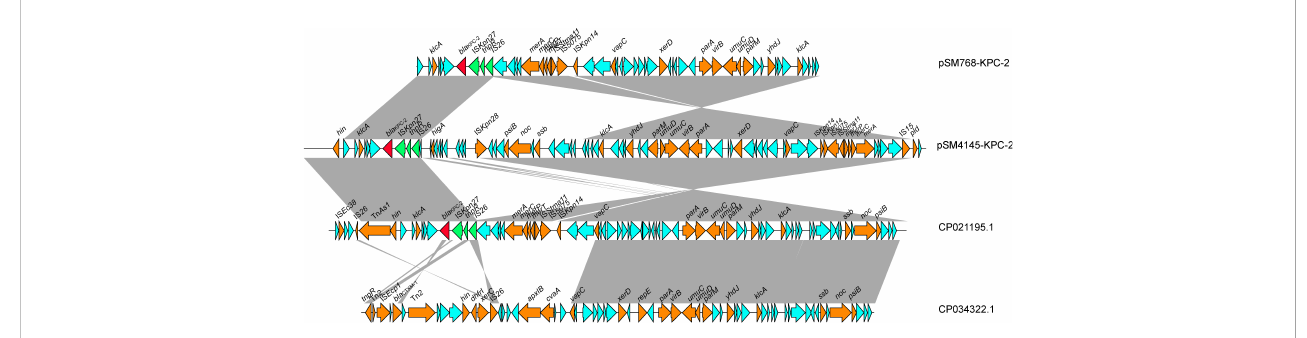
FIGURE 3 Colinear genome alignment of pSM768-KPC-2, pSM4145-KPC-2, pH17-2, and pK033_1. Arrows represent the direction of transcription. Red open reading frames (ORFs) indicate KPC-2.